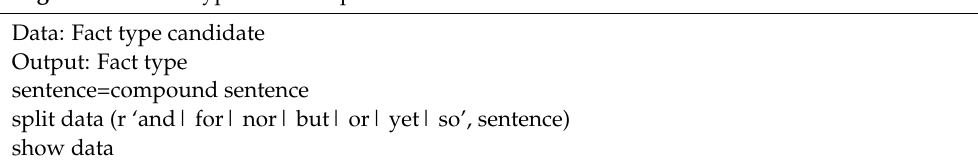
Algorithm 4. Fact type from compound sentence